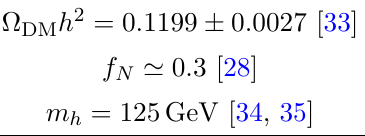
Table 1 . DM relic abundance and input values for parameters in eq. (3.1).